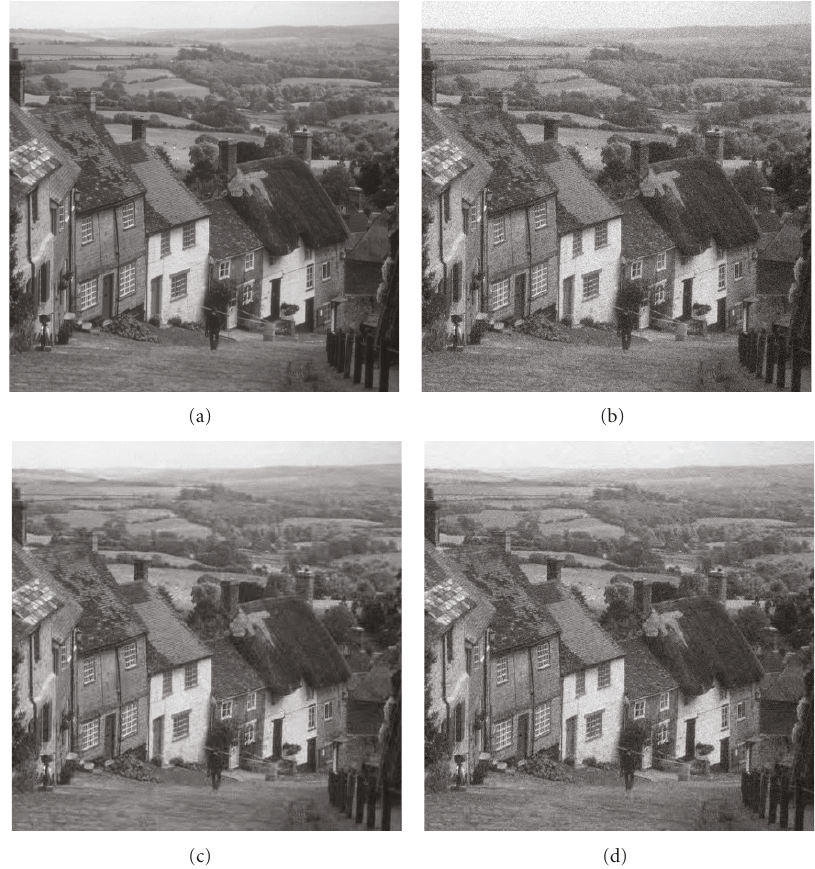
Figure 8: Image Goldhill: (a) noise-free, (b) noisy, σ 2 = 100, (c) compressed by ADCTC, b = 3 . 5, (d) compressed by AGU b = 3 . 5.